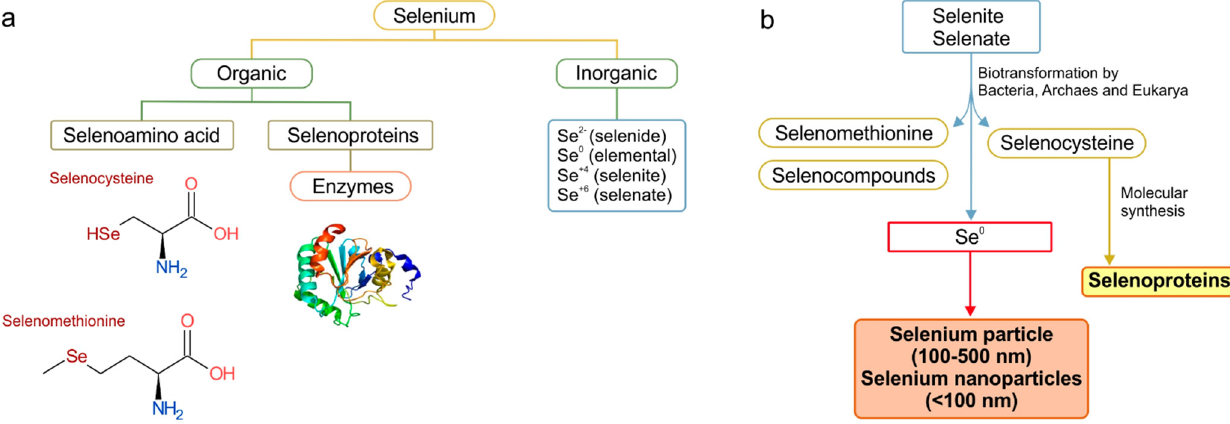
Figure 1. Selenium; ( a ) forms of organic and inorganic selenium; and ( b ) biotransformation of selenite and selenate in organic forms.